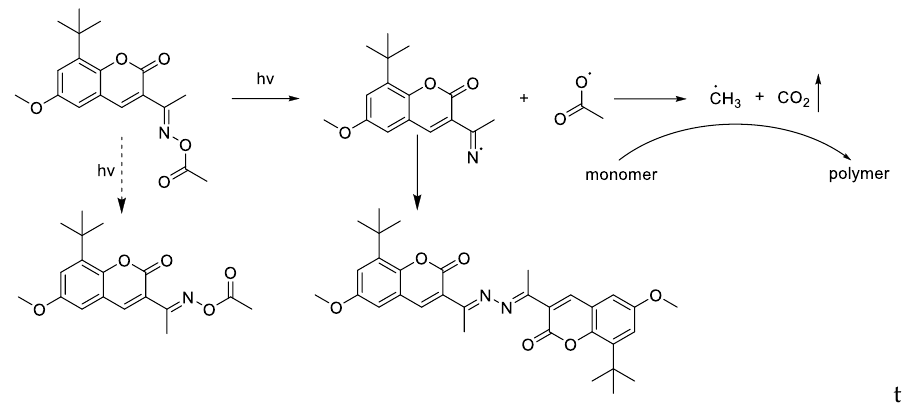
12 of 23 Figure 6. Steady-state photolysis curves measured for ( a ) COXE-C, ( b ) COXE-O, ( c ) COXE-N and ( d ) COXE-S in acetonitrile under 400 nm LED irradiation (light intensity = 100 mW··cm- – 2 ) at room temperature. 3.3.3. Proposed Photolysis Mechanism Different LC signals and similar mass spectra obtained for COXE- O by LC‒MS meas-